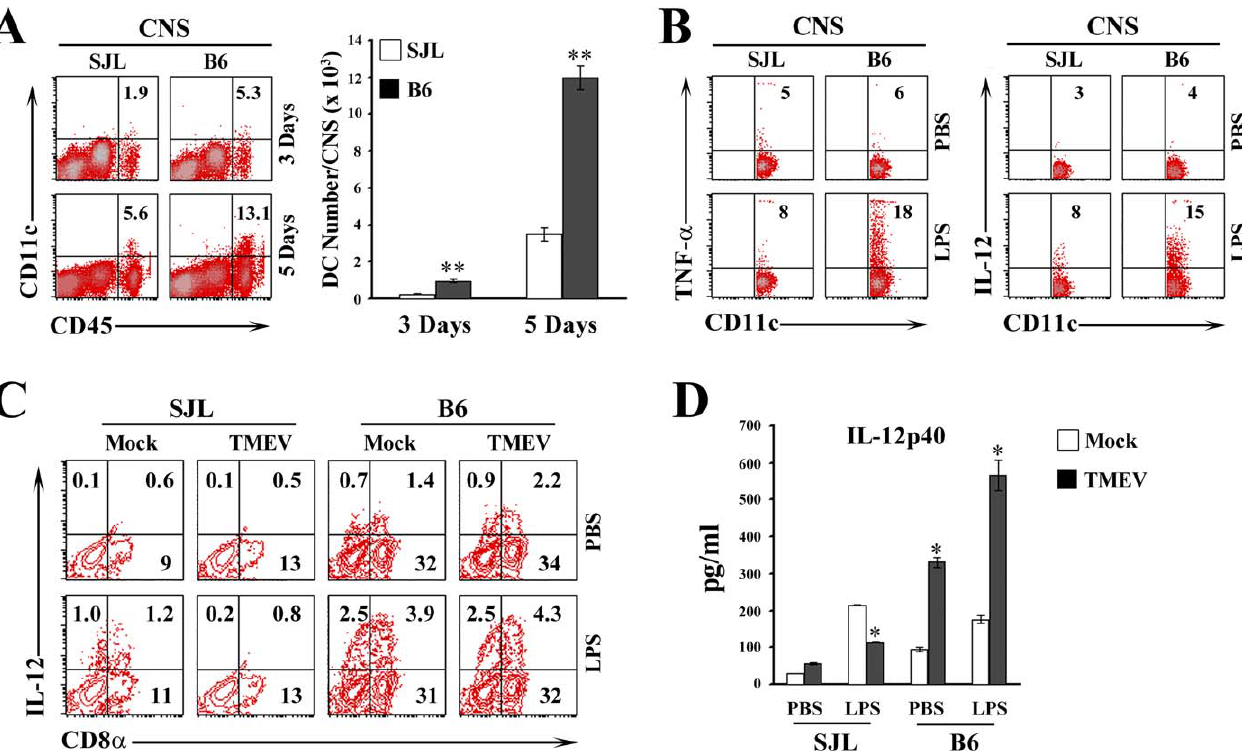
Figure 5. Reduced Number and Ability of DCs to Produce Cytokines in TMEV-Infected SJL